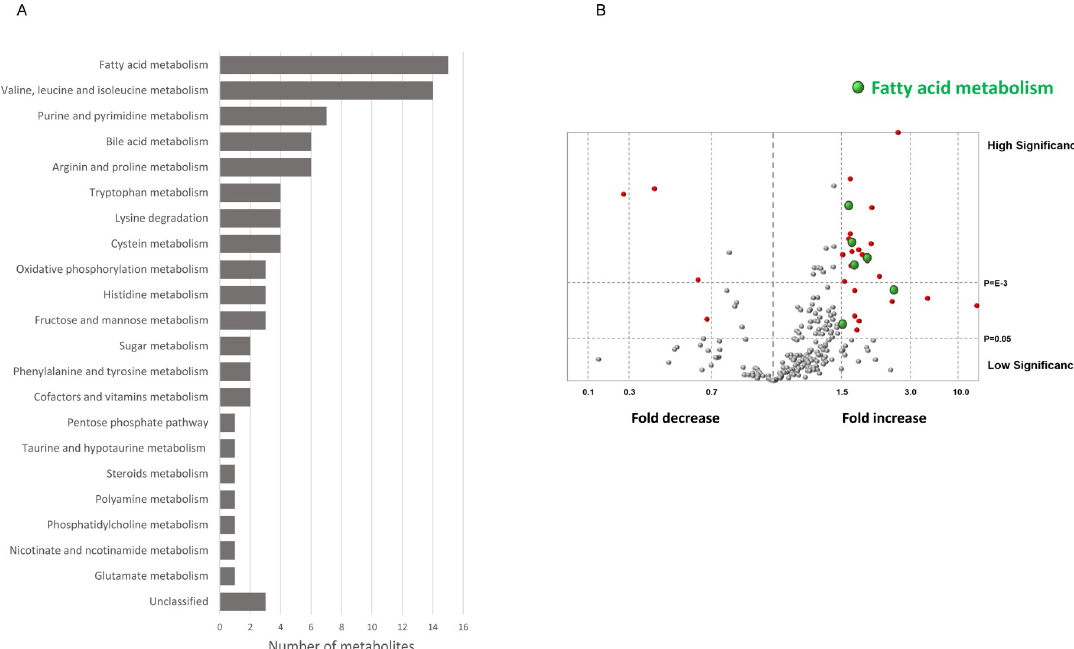
Fig 4. Effects of CANA on metabolites evaluated by metabolomics. A) The number of significantly altered metabolites between the CANA and CON groups was plotted according to each category of metabolism. B) Volcano plot of differential metabolomics between the CON and CANA groups. Red circle indicates differential metabolites, which determined the condition of > 1.5-fold increase with P < 0.05 or < 0.7-fold decrease with P < 0.05. The green circle indicates differential metabolites associated with fatty acid metabolism. The gray circle indicates non-differential metabolites, which determined the condition of � 1.5-fold increase and � 0.7-fold decrease with P < 0.05 and non-differential metabolites with P � 0.05. Abbreviations: CON, control; CANA, canagliflozin.